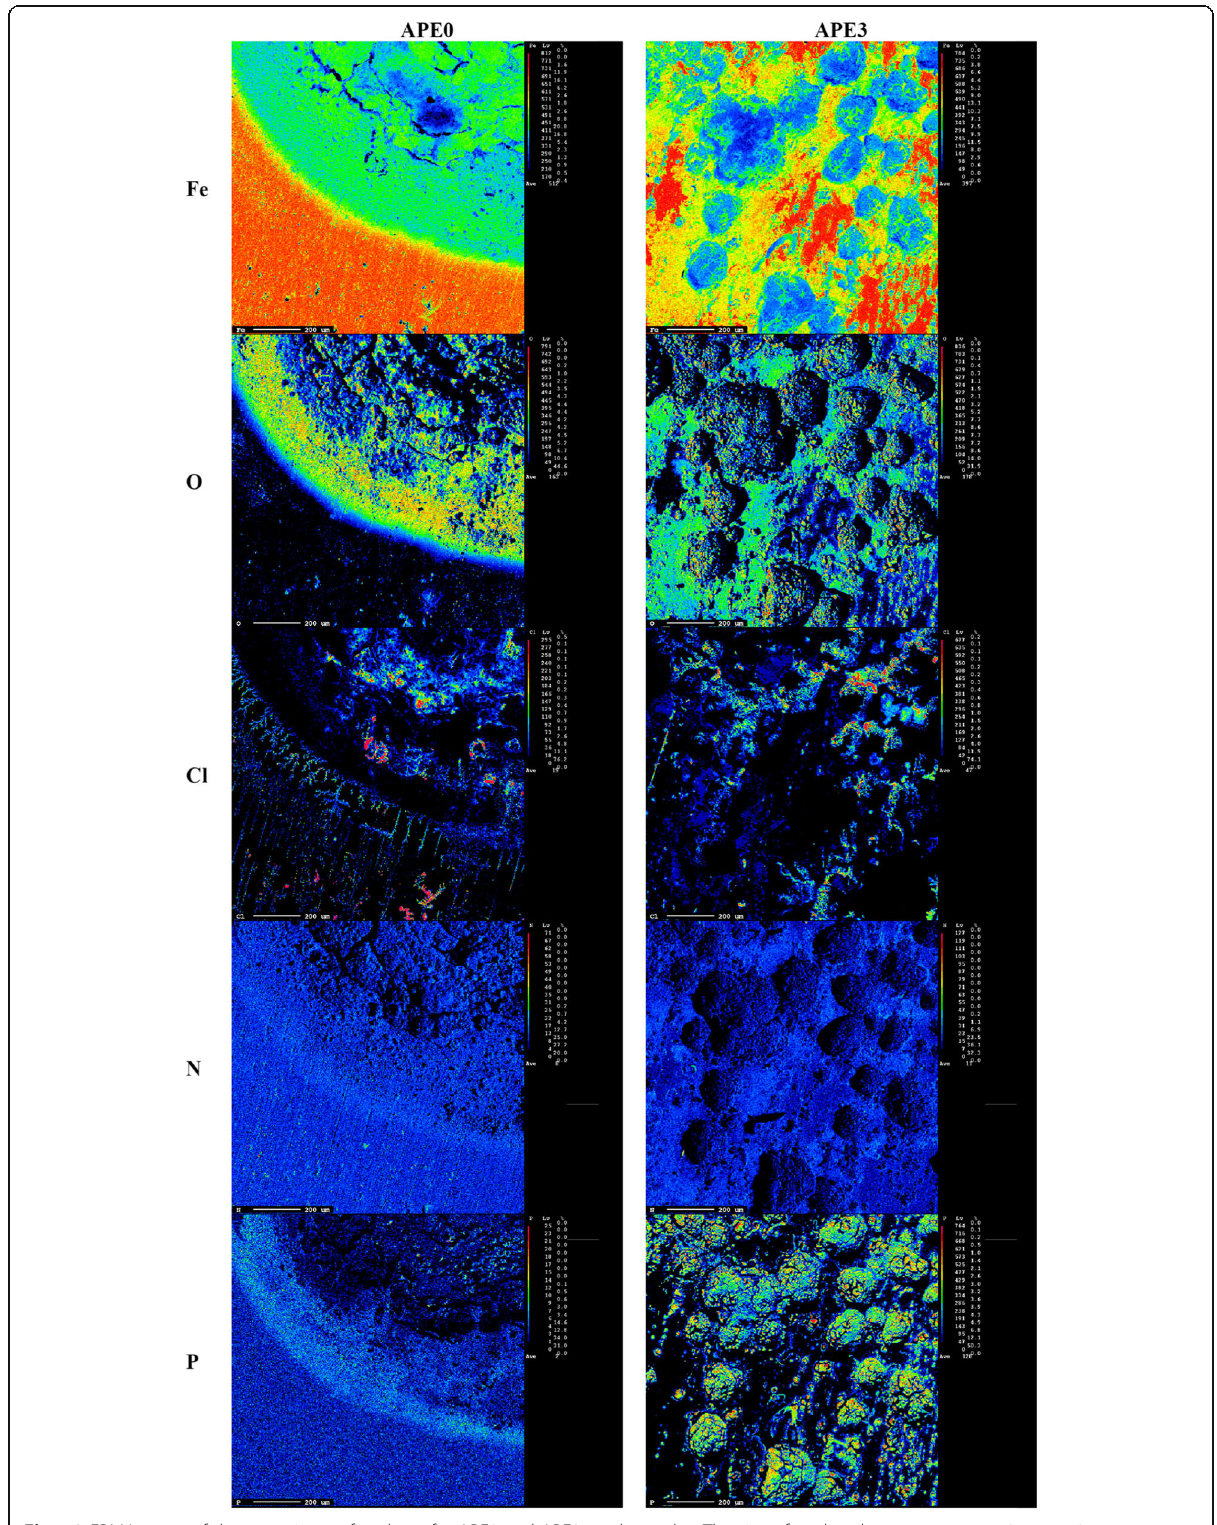
Fig. 13 EPMA maps of the corrosion surface layer for APE0 and APE3 steel samples. The size of analyzed area was set at 50 μ m × 50 μ